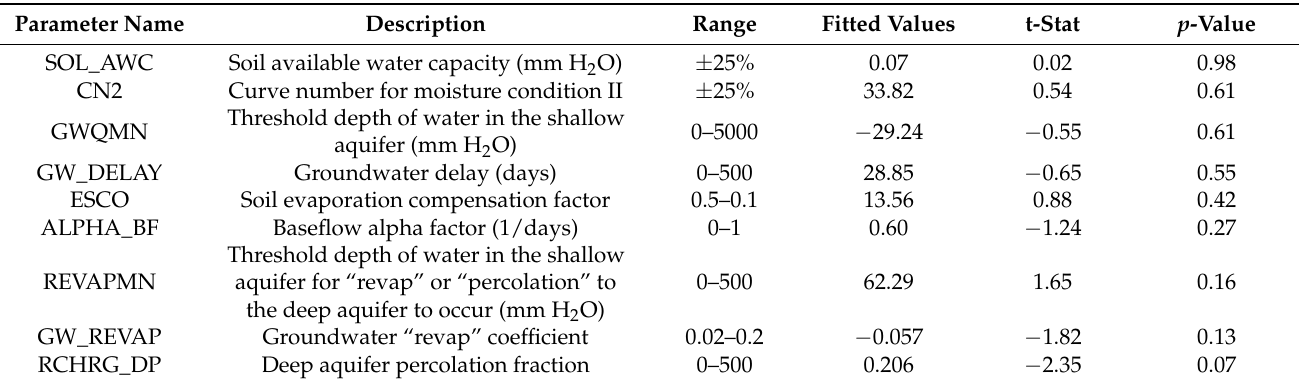
Table 3. Fitted values of calibrated flow parameters with absolute t-stat and p -value for the SWAT model.